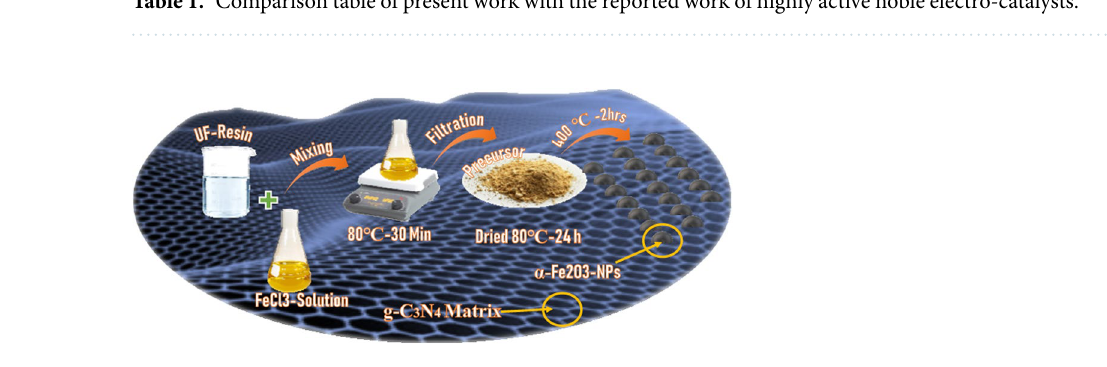
Table 1. Comparison table of present work with the reported work of highly active noble electro-catalysts.